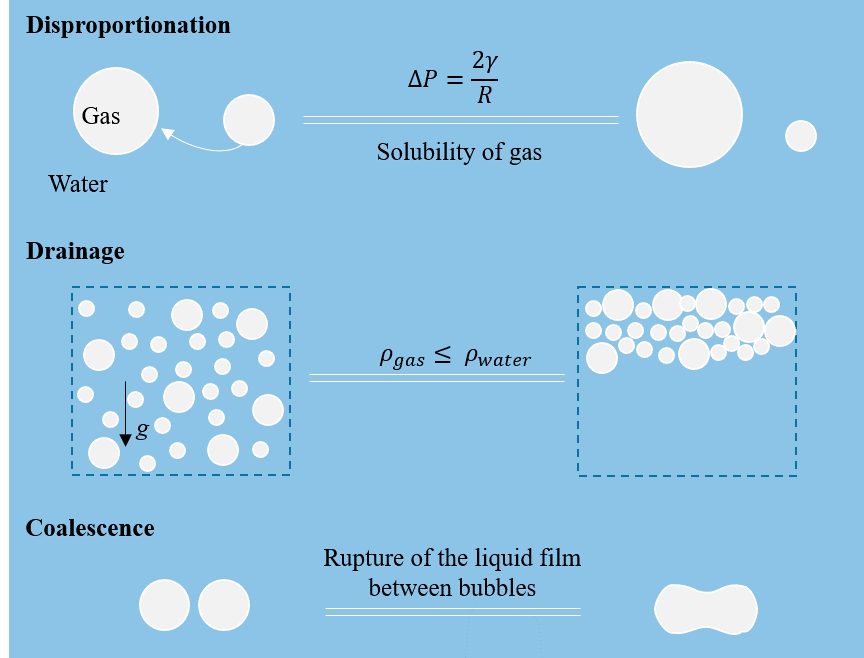
Figure 1. Illustration of the three main destabilization mechanisms of foams, from top to bottom: Disproportionation, drainage, and coalescence.